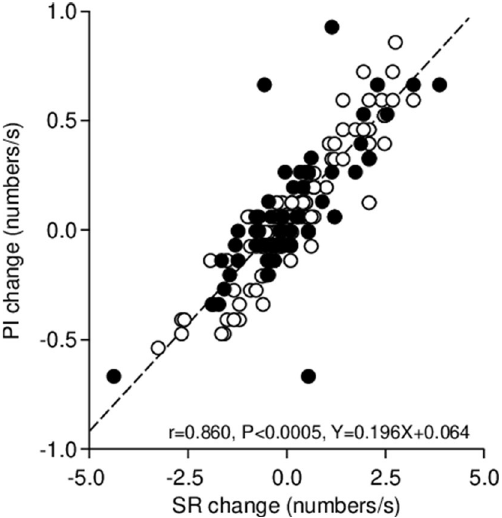
Figure 5. Relation between changes in the PI and the SR induced by modifying arches position and occlusal condition. The dotted line represents the regression line of all the plotted points, whose equation has been reported in the plot. Dots and circles refer to TMJ disorders/edentulous and normal subjects, respectively.